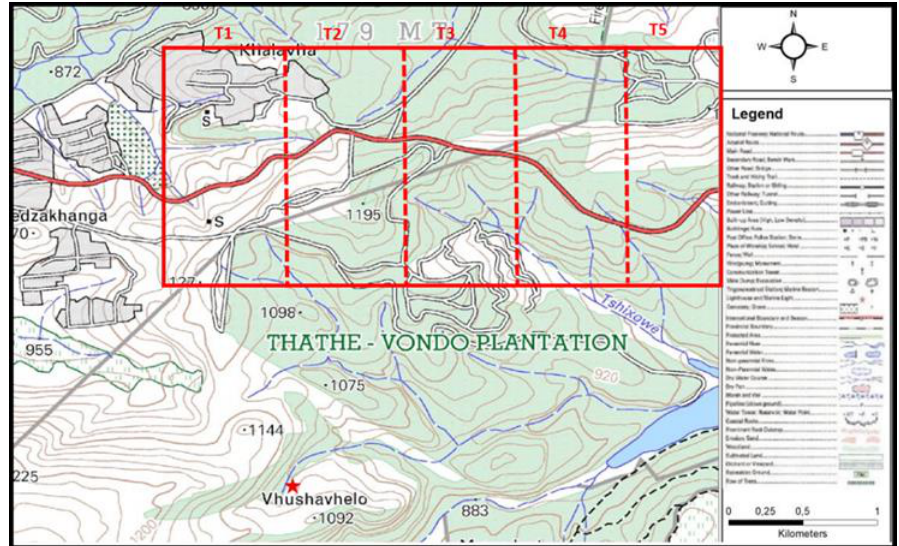
Figure 2. Topographical map of the study area with the designed traverses across the area of interest.